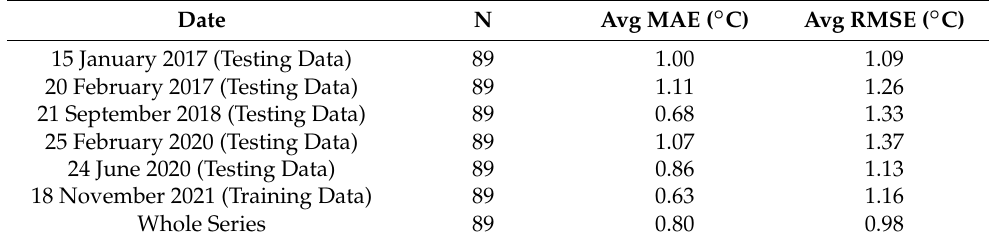
Table 1. Results from five testing case studies, one training case study, and whole time